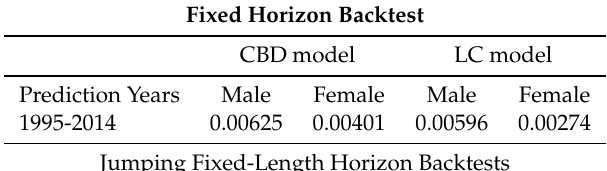
Table 4. Root Mean Squared Errors (RMSE) between observed q O